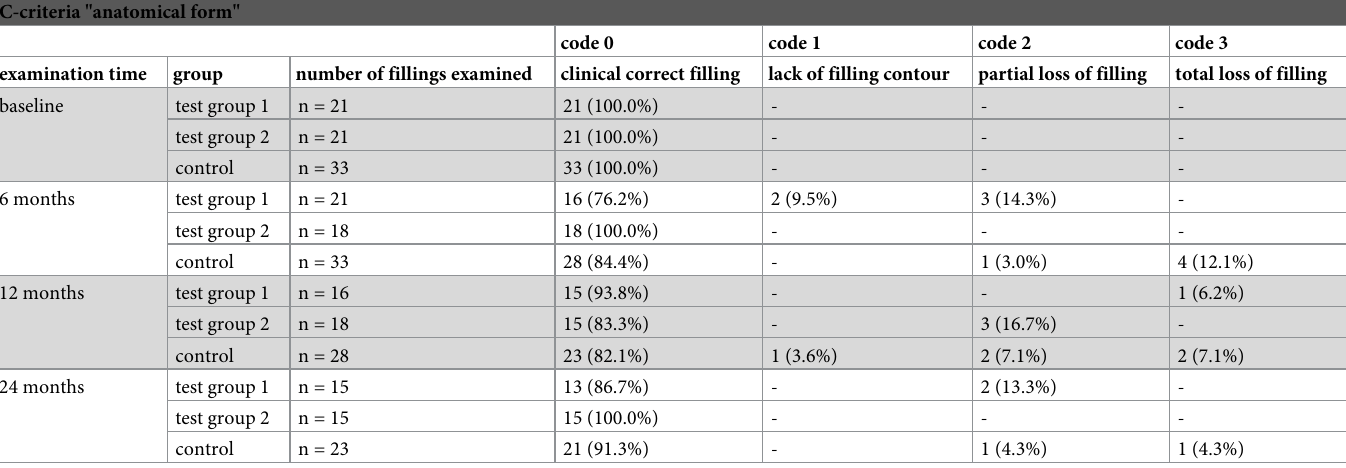
Table 2. Results evaluated according to the C-criteria “anatomical